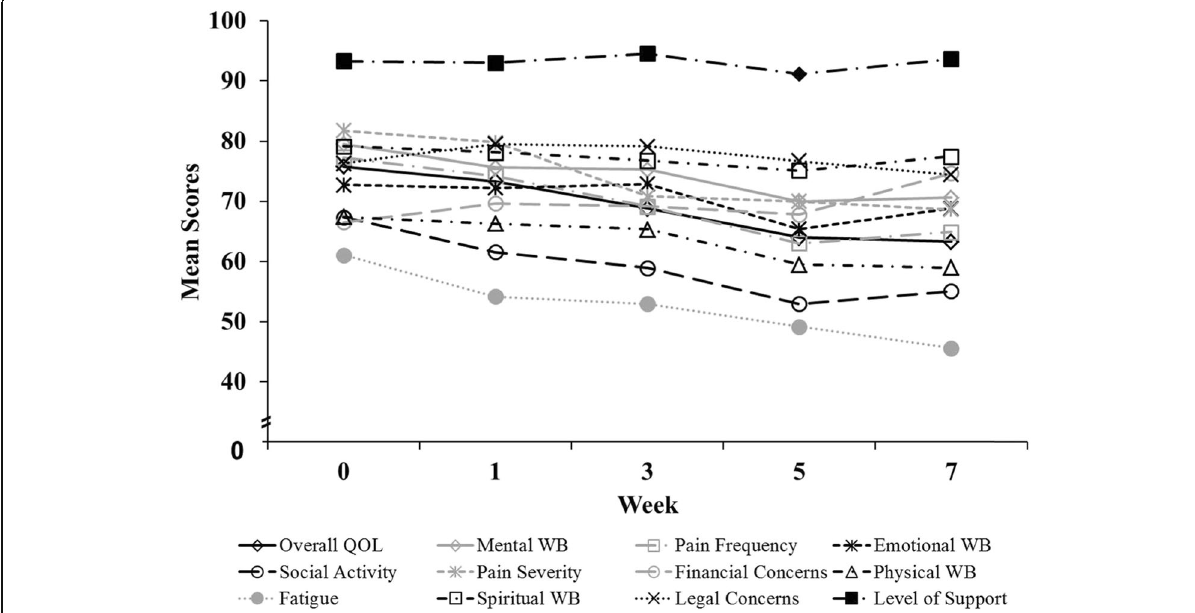
Fig. 1 Average LASA scores from baseline to RT completion (0 = Low QOL; 100 = High QOL). Abbreviations: LASA, linear analog self-assessment; QOL, quality of life; WB, well-being. Previously published data [Niska